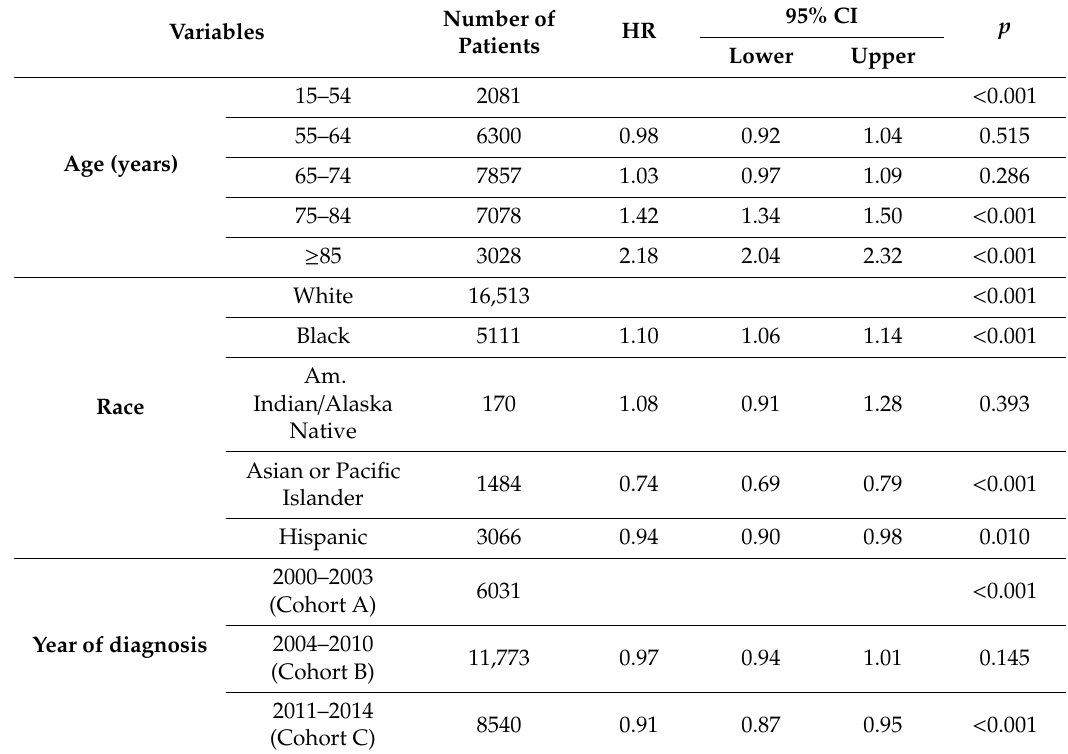
Table 2. Multivariable analysis for OS.